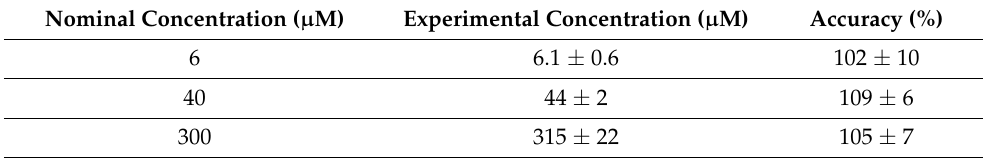
Table 2. Accuracy data.